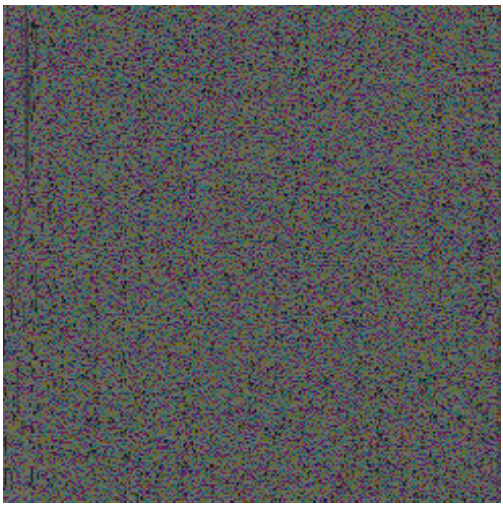
Figure 2. Result for file data1.txt with variant 1 (extended ASCII coding).